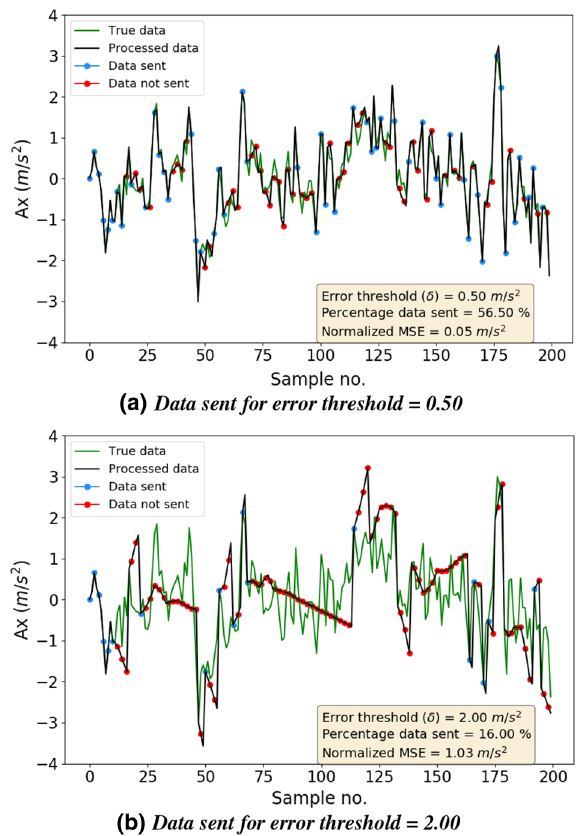
Figure 3. Data sent for various error thresholds. Expectedly, as the threshold becomes higher, fewer data points are sent and the deviation between the true data and the processed data also